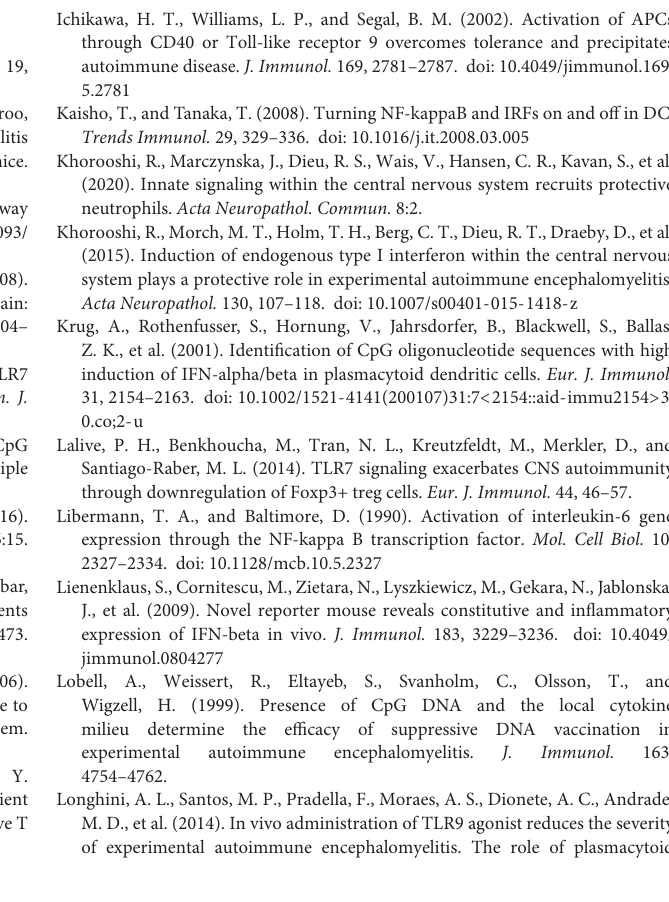
Supplementary Figure 1 | Clinical scores of individual C57BL/6 mice with EAE that received CpG. Individual clinical scores of mice with EAE treated with CpG or vehicle (Ctrl). C57BL/6 mice were immunized with MOG35-55. At first sign of disease (day 0), mice received intrathecal injection of CpG or vehicle. A cross indicates the timepoint where a mouse was euthanized. Supplementary Figure 2 | Clinical scores of individual C57BL/6 mice with EAE that received Imiquimod. Individual clinical scores of mice with EAE treated with Imiquimod (Imiq) or vehicle (Ctrl). C57BL/6 mice were immunized with MOG35-55. At first sign of disease (day 0), mice received intrathecal injection of Imiquimod or vehicle. A cross indicates the timepoint where a mouse was euthanized. Supplementary Figure 3 | Clinical scores of individual IFNAR1-KO mice with EAE that received CpG. Individual clinical scores of mice with EAE treated with CpG or vehicle (Ctrl). C57BL/6 mice were immunized with MOG35-55. At first sign of disease (day 0), mice received intrathecal injection of CpG or vehicle. Supplementary Figure 4 | Intrathecal CpG induces Arginase1. Brains and spinal cords were analyzed 4 and 24 h post intrathecal injection of CpG and Vehicle (Ctrl) into healthy C57BL/6 mice. Bar graphs show mRNA levels of Arginase1 (Arg1) ( n = 3–5 per group). Results were analyzed using the two-tailed Mann–Whitney U -test. Data are presented as means ± SD. ∗ p <